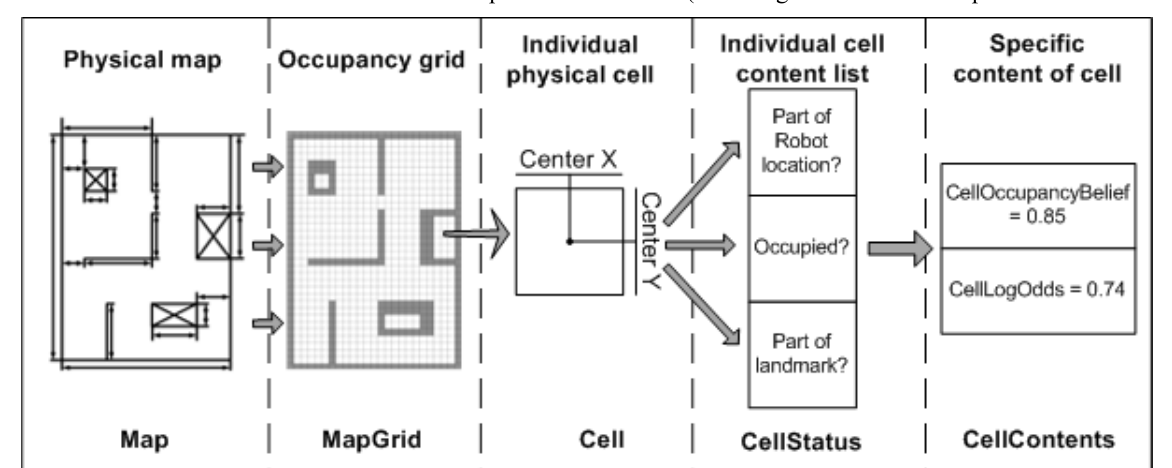
Fig. 2. The architecture of the mapping system